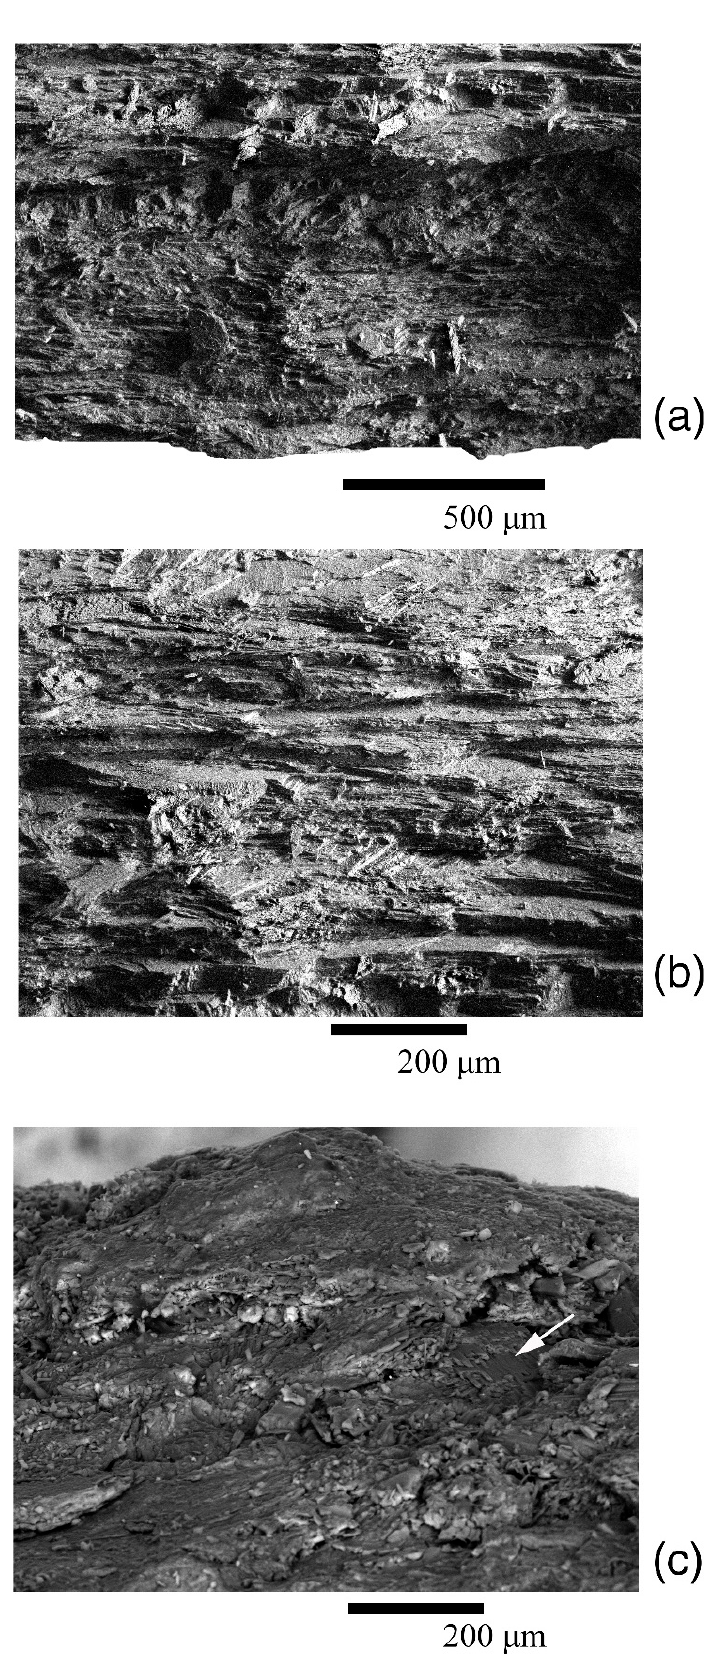
Figure 6. Microstructure of valves of the Gryphaea dilatata Sowerby, 1816: ( a , b ) split of the left valve; ( c ) friable white layer, the white arrow shows the elements of the microstructure, Oryol region, Kromy district, sand quarry near the village of Sukhochevo, Middle Jurassic, Middle Callovian. When analyzing the outer layer using an electron microscope, it was revealed (Figure 6c ) that the friable substance contains elements of the microstructure in the form of separate and grouped plates. There are also clusters of irregularly-shaped globules. The